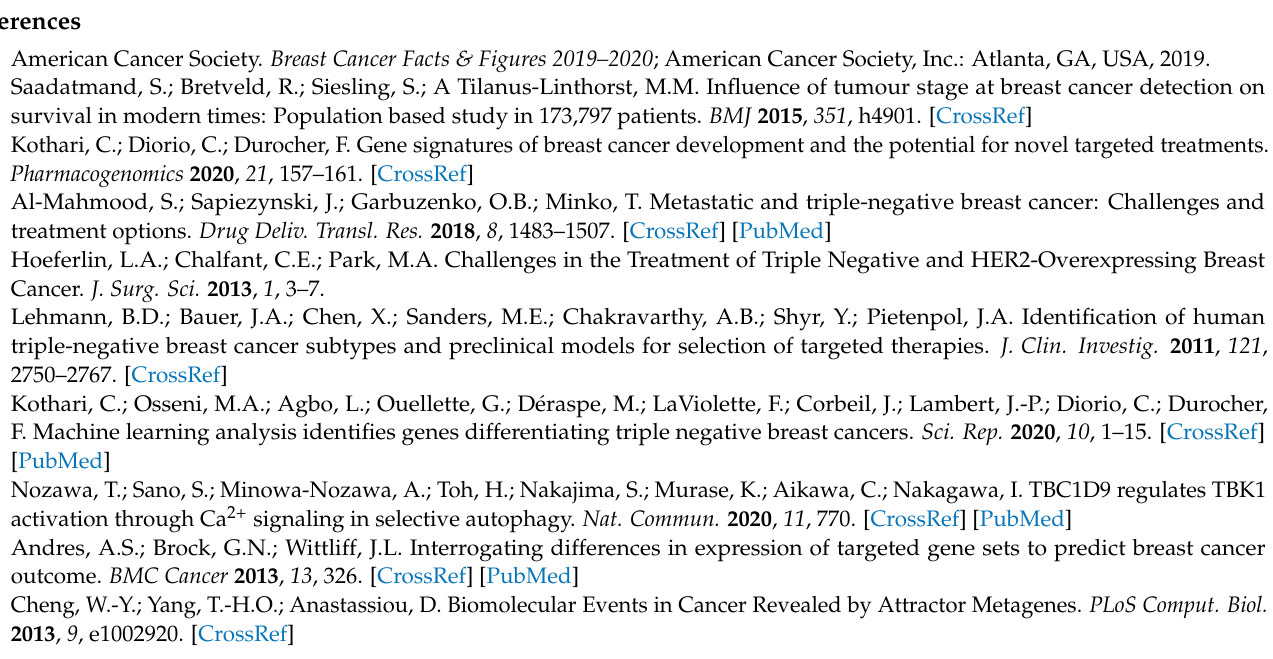
Table S2: Primer